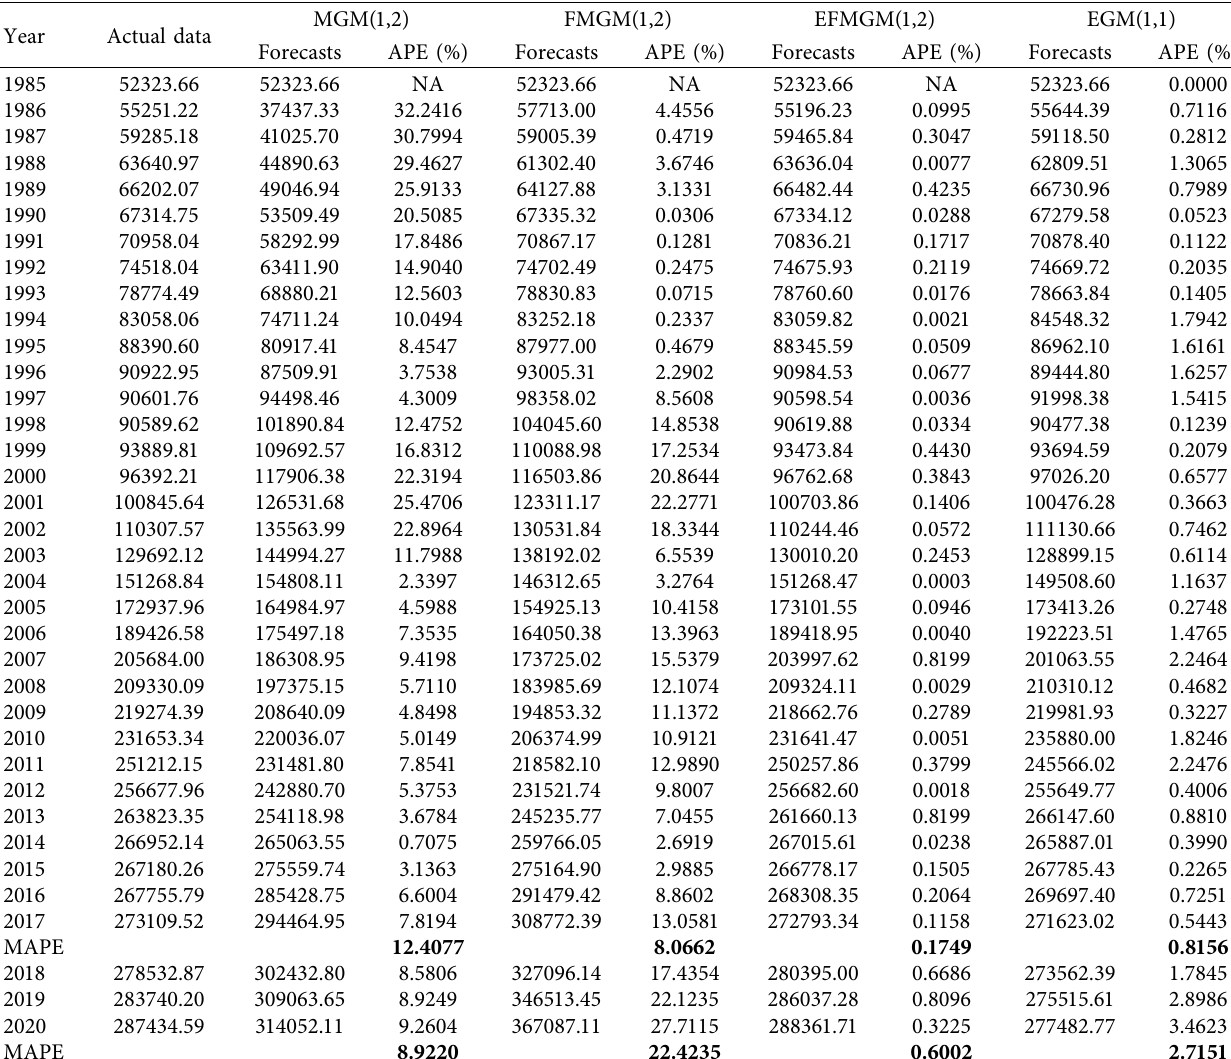
Table 3: Actual carbon emissions and MGM(1,2), FMGM(1,2), EGM(1,1), and EFMGM(1,2)